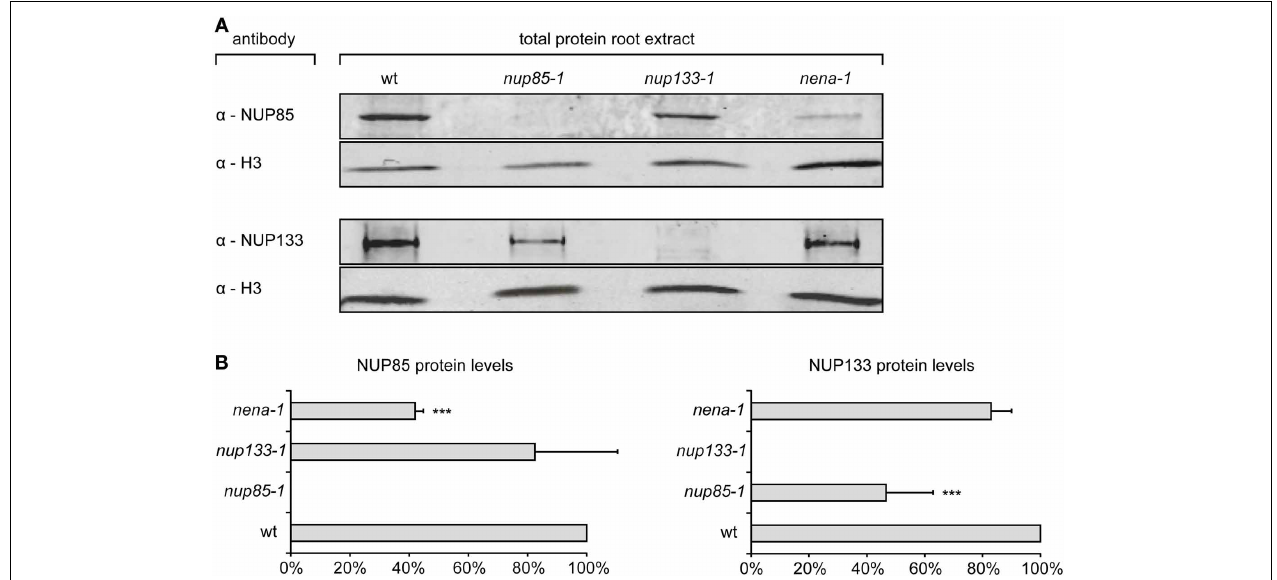
were normalized by the histone H3 signal and shown as percentages of wild type levels (wt). Mean protein levels were averaged from three independent